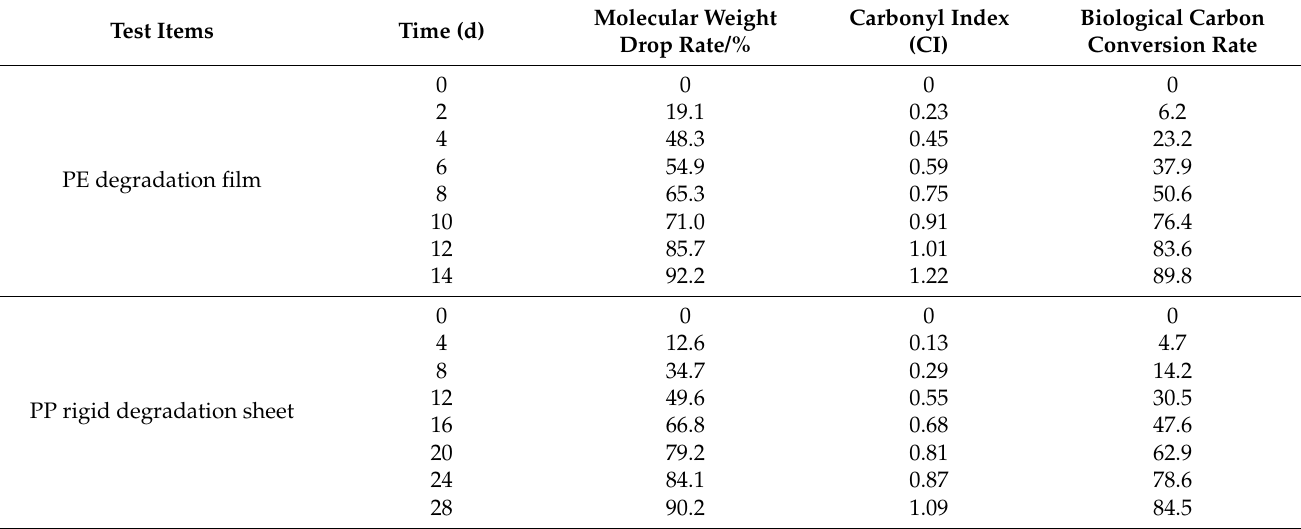
Table 3. Test analysis of carbonyl index, molecular weight and bioassimilated carbon conversion rate of PE and PP